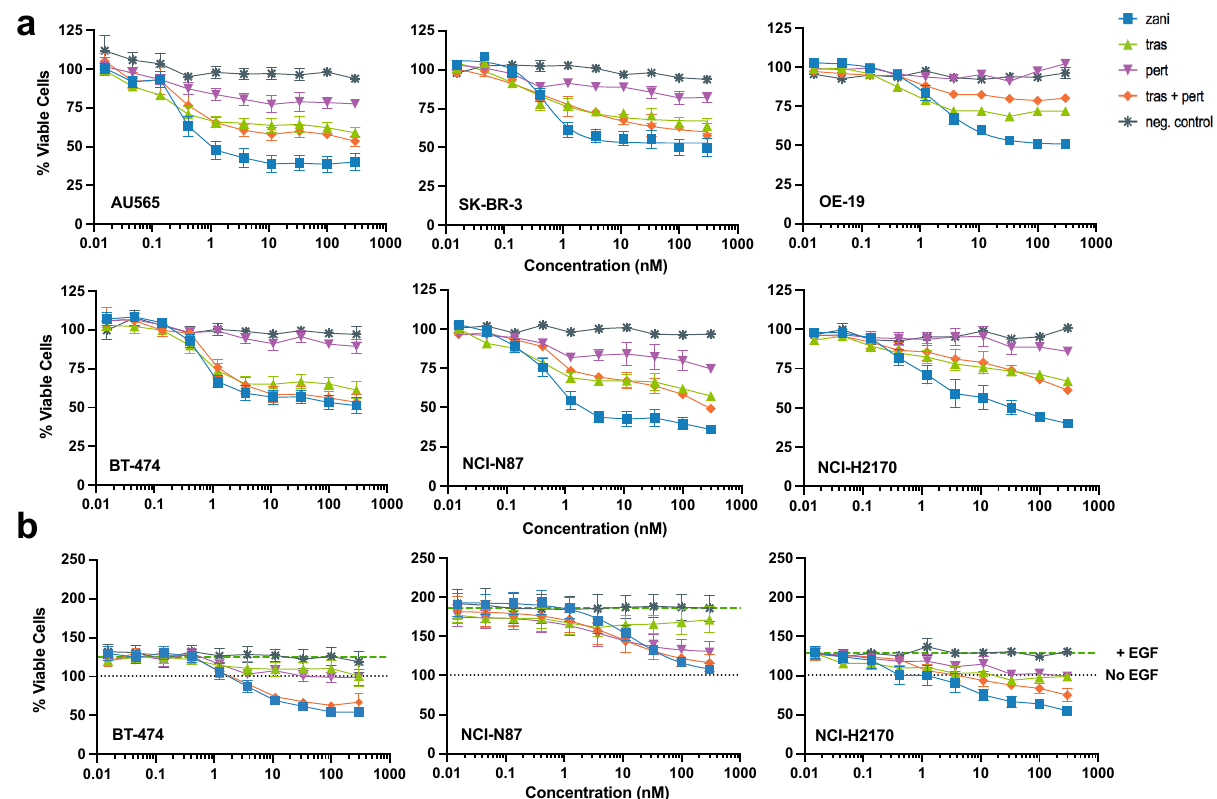
Fig.6|Zanidatamabmediatesligand-independentandEGF-dependentgrowth inhibition in HER2-expressing tumor cells. a Zanidatamab mediated ligand- independent tumor growth inhibition in HER2-expressing tumor cells including AU565, NCI-H2170, OE-19, BT-474, NCI-N87 and SK-BR-3 (HER2 3+). Data are mean±SEMfrom n =3(SK-BR-3), n =4(OE-19), n =6(AU565,BT-474,NCI-H2170)or n =12 (NCI-N87) independent experiments. See Supplementary Tables 6, 7 for complete data and pairwise comparisons, respectively. b Zanidatamab mediated EGF-dependent tumor growth inhibition in HER2-expressing cell lines, including